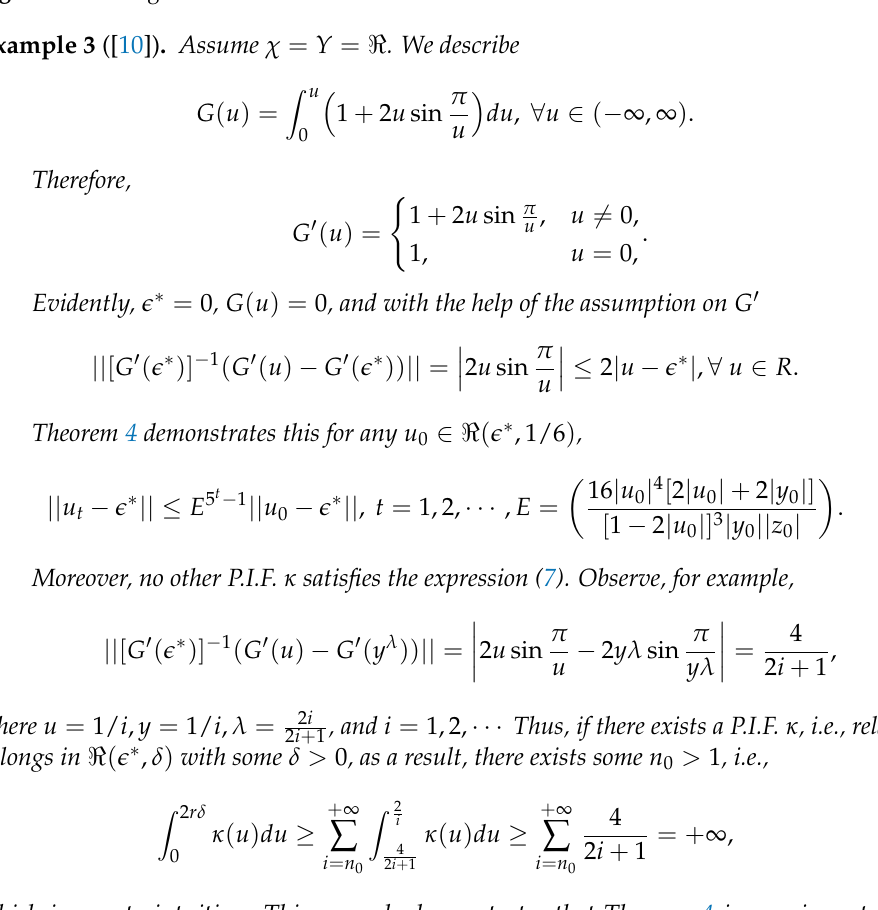
Figure 2. Convergence radius for different cases of κ